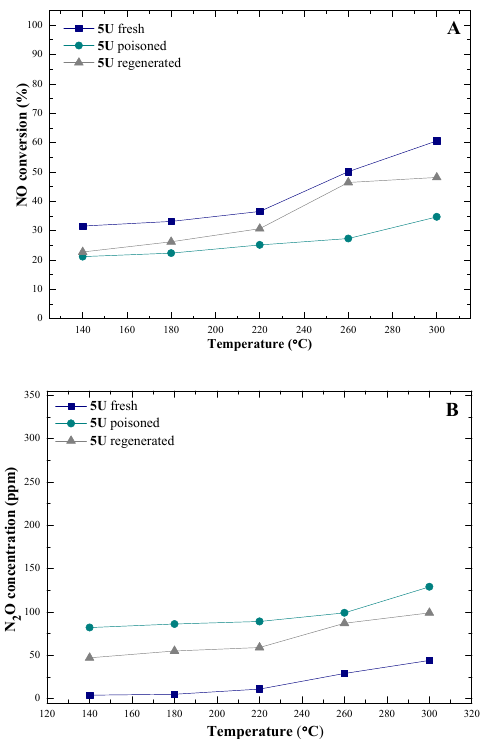
Figure 6. Results of catalytic tests carried out over fresh, poisoned, and regenerated 5U: ( A ) NO conversion; ( B ) N 2 O concentration.